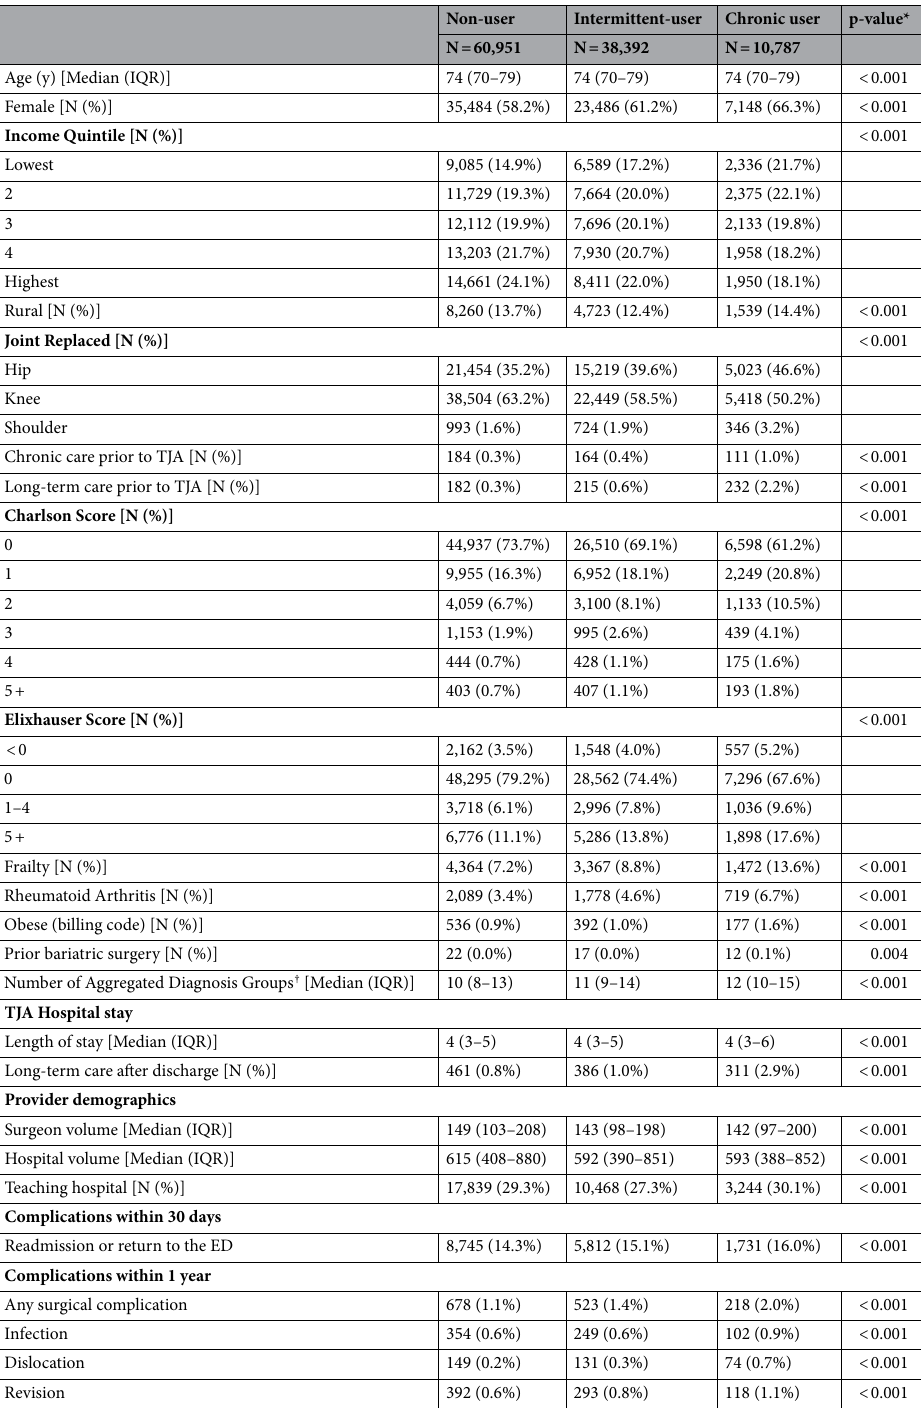
Table 1. Baseline characteristics of entire cohort stratified by pre-operative opioid use. IQR interquartile range. *P-value testing the hypothesis of no difference among the three groups of opioid users. † The Johns Hopkins ACG System Version